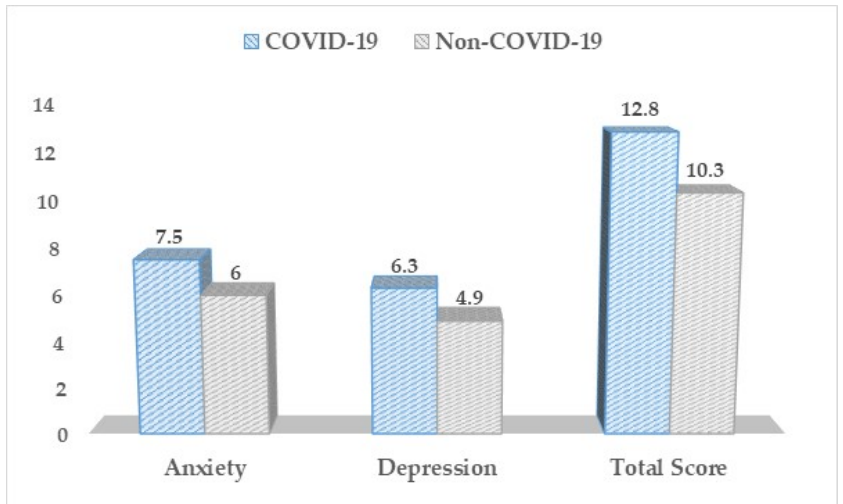
Figure 1. Comparison between COVID-19 positive and COVID-19 negative pregnant women based on their high likelihood of using the coping mechanisms determined by the COPE-60 survey.